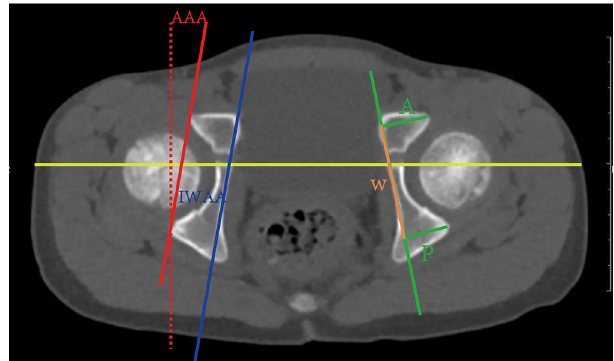
Figure 2. Measurement methods: The baseline (yellow line) was obtained by connecting the center of the bilateral Y-shaped cartilage, and the vertical baseline was used as the reference line (red dotted line). The anterior and posterior margins of the bone acetabulum were connected (red solid line), and the angle of intersection with the reference line was the AAA. A parallel line (blue line) was made through the straight bone cortex of the inner wall of the pelvis, and the angle of intersection with the reference line was the IWAA. The distance from the highest point of the anterior and posterior margins of the bony acetabulum to the straight line of the pelvic wall was the A (green line) and P (green line), respectively. The distance from the point of the projection of the highest point of the anterior and posterior walls onto the straight line of the pelvic wall was the W (brown line).